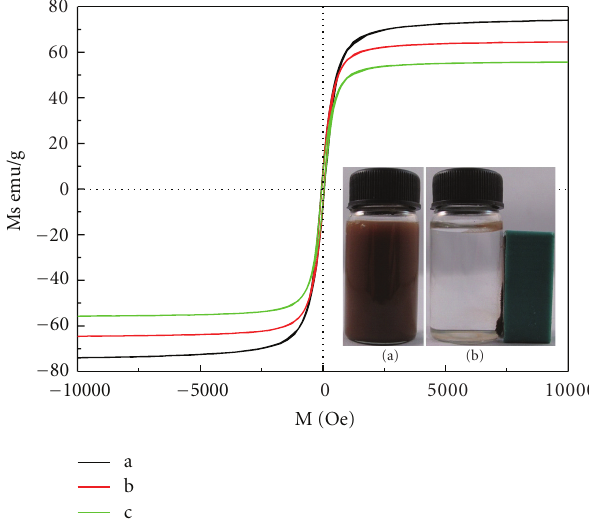
Figure 5: Room-temperature magnetization curves of a: Fe 3 O 4 ; b: Fe 3 O 4 /C; c: Sample B; Sample B separated from aqueous solution by an external magnetic field